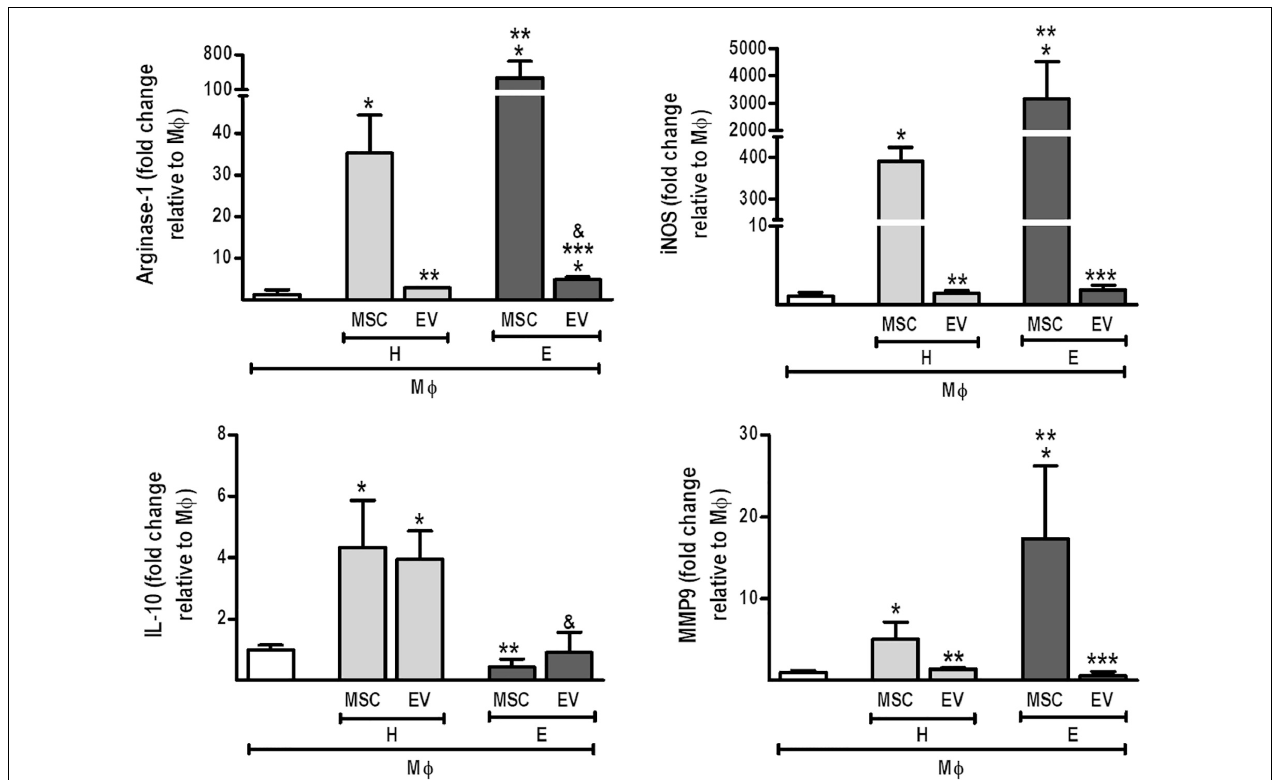
FIGURE 6 | Direct co-culture of MSCs and EVs from healthy or emphysematous donors modulates the alveolar macrophage (M (cid:56) ) profile. H-MSCs, 1 × 10 6 bone marrow-derived mesenchymal stromal cells (BM-MSCs) obtained from healthy donors; E-MSCs, 1 × 10 6 BM-MSCs obtained from emphysematous donors; H-EVs, extracellular vesicles derived from 1 × 10 6 BM-MSCs obtained from healthy donors; E-EVs, extracellular vesicles derived from 1 × 10 6 BM-MSCs obtained from emphysematous donors. Data are expressed as medians (interquartile range) of 5–6 samples in each group. * P < 0.05 vs. M (cid:56) . ** P < 0.05 vs. the H-MSC. *** P < 0.05 vs. the E-MSC. & P < 0.05 vs. the H-EV.